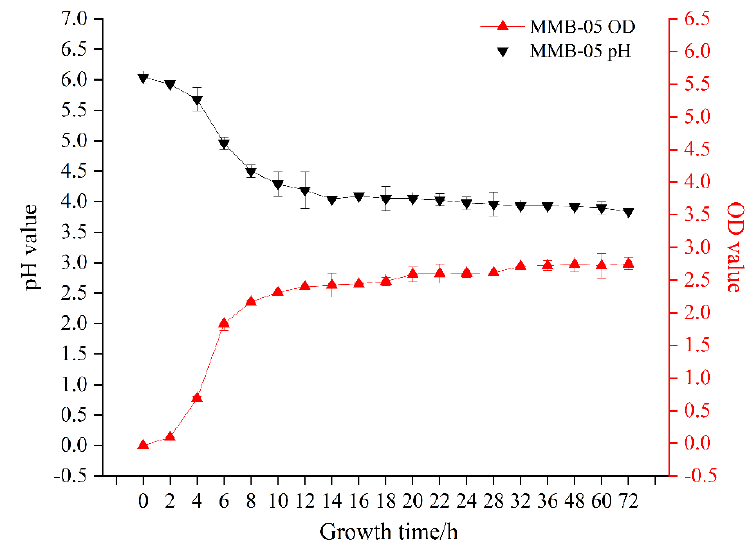
Figure 1. Growth and pH changes in L. plantarum MMB-05.